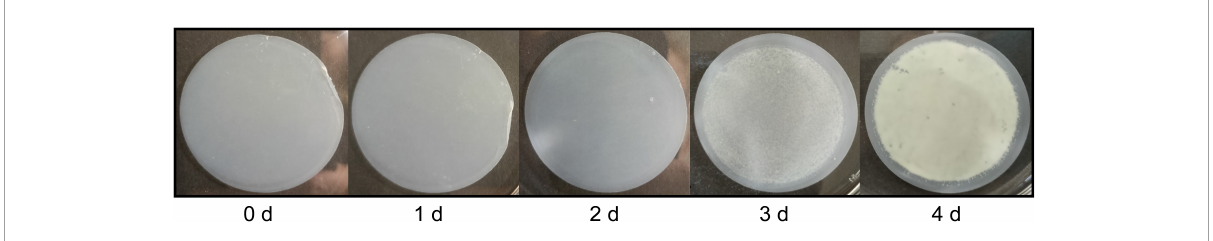
FIGURE1 Time-dependent Sulfolobus acidocaldarius MW001 biofilm formation on the hydrophilic PTFE membrane. Membranes were inoculated with 6 × 10 5 cells/membrane, equivalent to a cell density of 3.5 × 10 4 cells/cm 2 . Cultivation was performed statically floating on liquid Brock medium (pH 3.0) supplemented with 0.1% ( w/v ) NZA, 0.2% ( w/v ) glucose, 10 µ g/mL uracil, at 76 ◦ C. Biofilm formation was documented by camera every day. After 4 days of cultivation the confluent biofilm was harvested. A cell density of 3.4 × 10 9 cells/cm 2 was determined after 4 d ( Supplementary Figure 3D ).